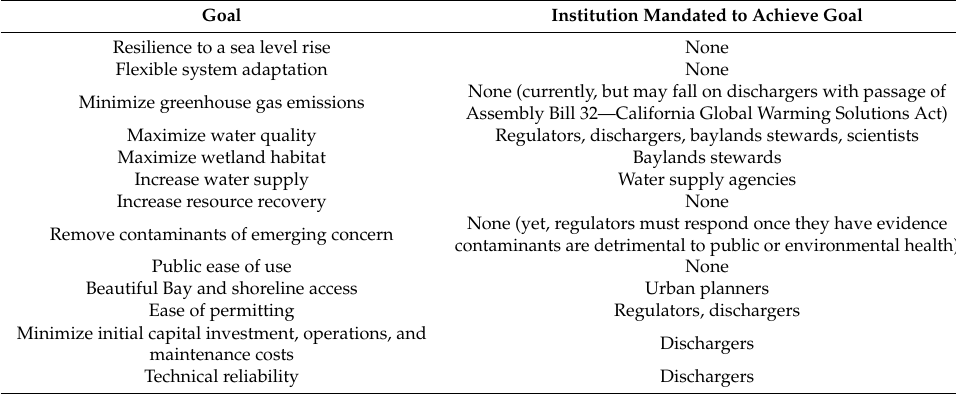
Table 2. Stakeholders institutionally mandated to fulfill stated goals for “good nutrient